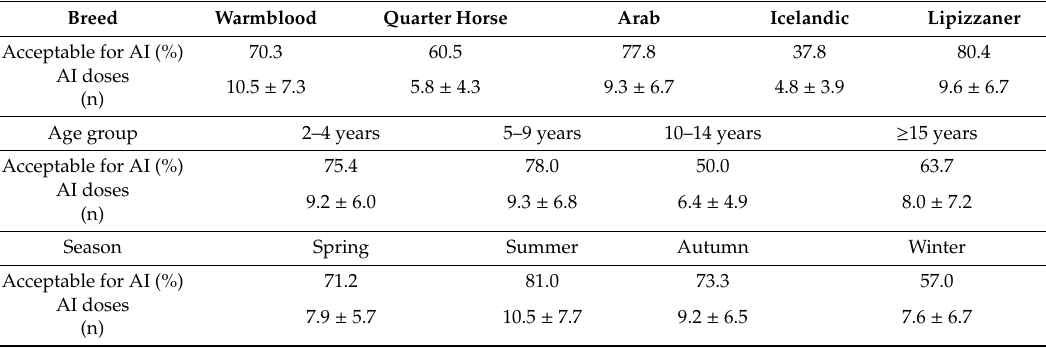
Table 3. Percentage of ejaculates acceptable for artificial insemination (AI) after cryopreservation (post-thaw progressive motility ≥ 35%) and number of insemination doses (250 × 10 6 progressively motile spermatozoa / dose; mean ± SD) in stallions of di ff erent breed and age and ejaculates frozen at di ff erent times of the